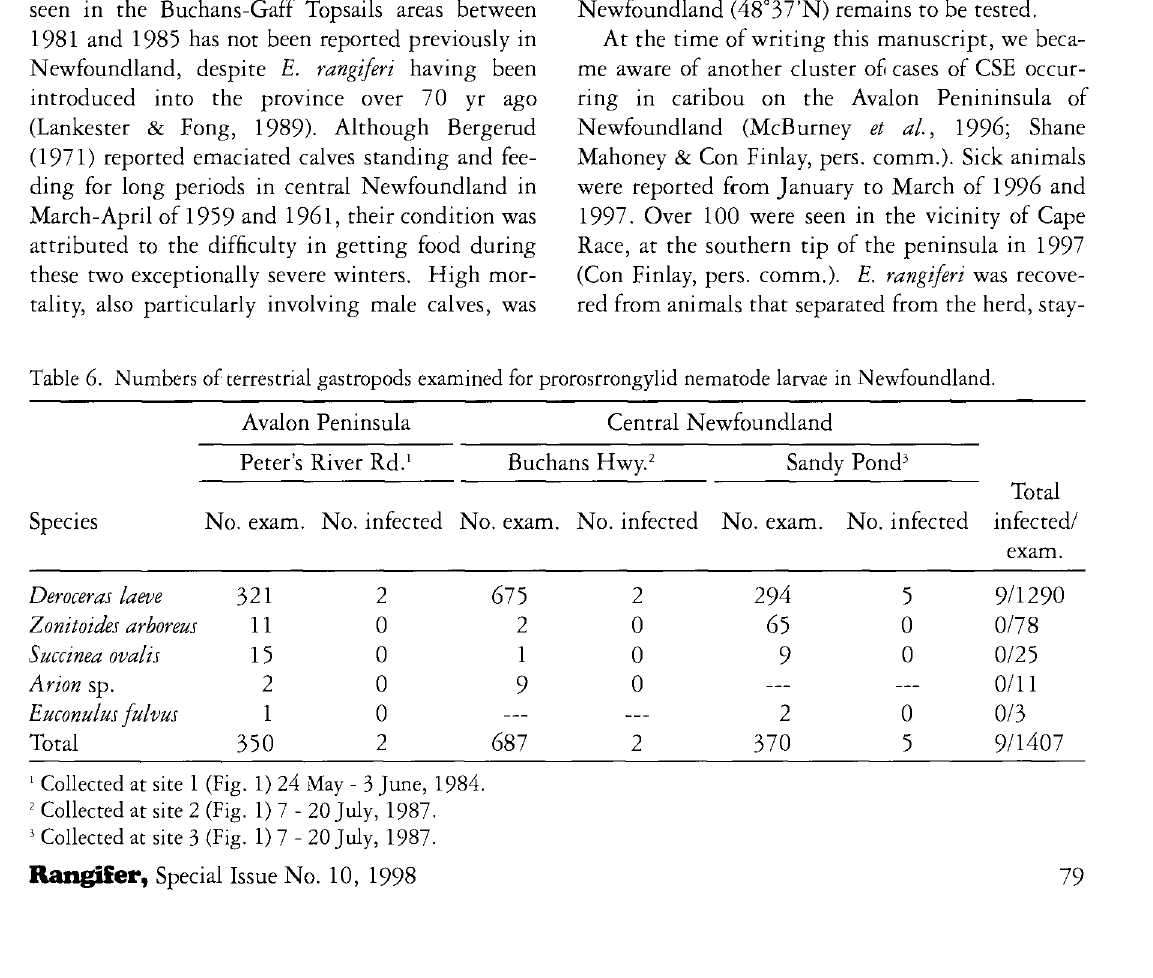
Table 6. Numbers of terrestrial gastropods examined for prorosrrongylid nematode larvae in Newfoundland. Avalon